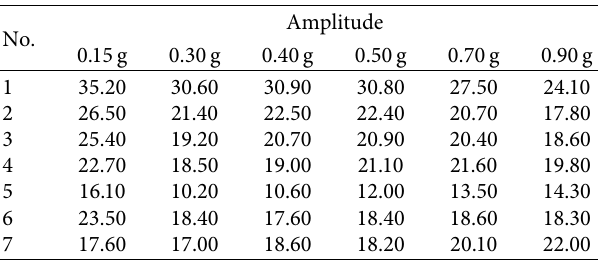
Figure 7: Amplification factors of the horizontal acceleration. (a) At the slope surface. (b) Inside the slope. Table 5: Initial prestress values of the prestressed anchor cables before each seismic excitation (Unit: N).